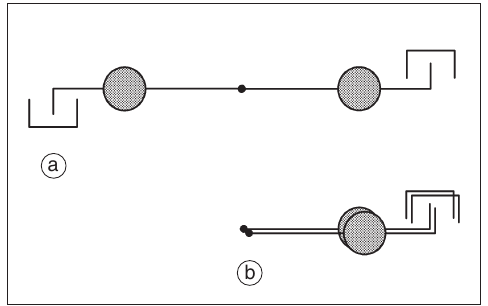
b Fig. 3a,b. Rotation seismograph: working (a) and cal- ibration (b) positions of the sensor